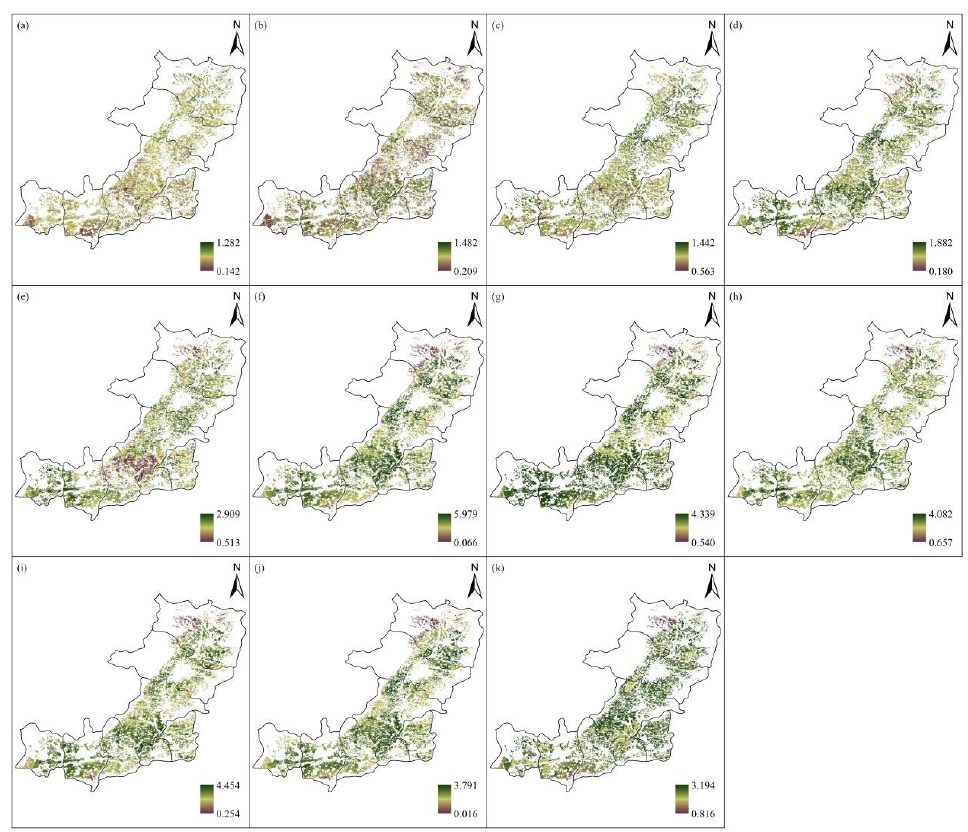
Figure 5. Spatial distribution pattern of daily evapotranspiration (ET) during the main growth period of winter wheat in Linfen Basin at intervals of 8 days: ( a – k ) represent ESTARFM ET on 2019066 (7 March),